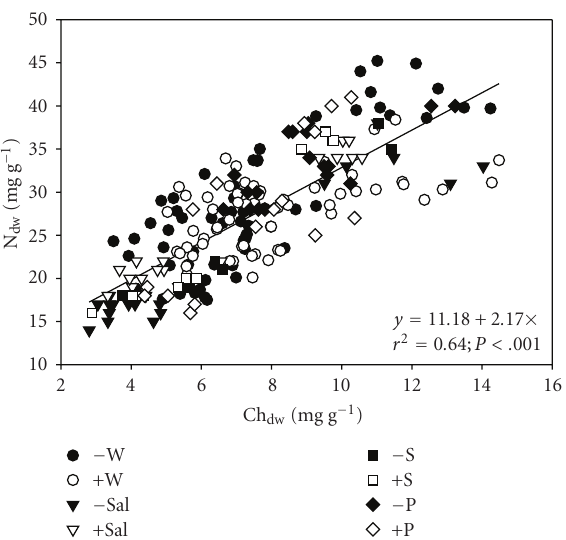
Figure 1: Leaf chlorophyll concentration (Ch dw ) versus leaf N con- centration (N dw ), both based on dry weight, in a 2005 greenhouse trial. Data from all samplings and treatments ( n = 210) were included for the linear regression analysis.